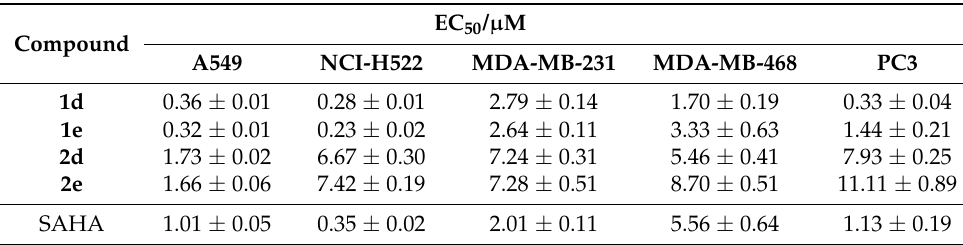
Table 2. Cytotoxic activity (mean half-maximal effective concentration (EC 50 ) ± SEM) of 1d and 1e and their Ru complexes 2d and 2e as compared to SAHA in human lung (A549, NCI-H522), breast (MDA-MB-231, MDA-MB-468), and prostate (PC3) cancer cell lines. EC 50 values were determined using the SRB assay after 72 h of